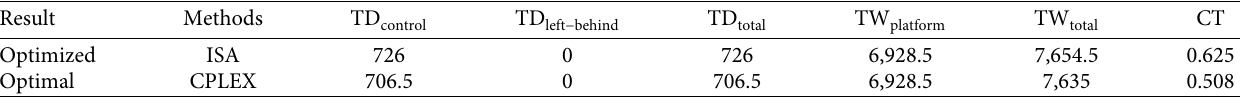
Table 8: Comparison of results for two kinds of methods (unit: